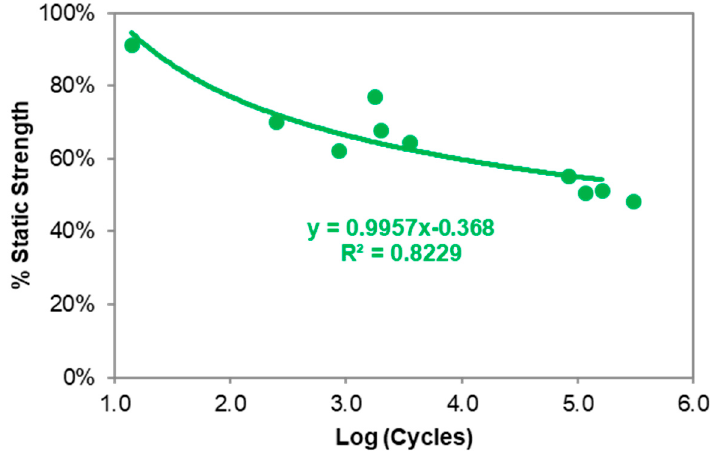
Figure 16. Fabric ILT fatigue. R = 0.1, 4 Hz.